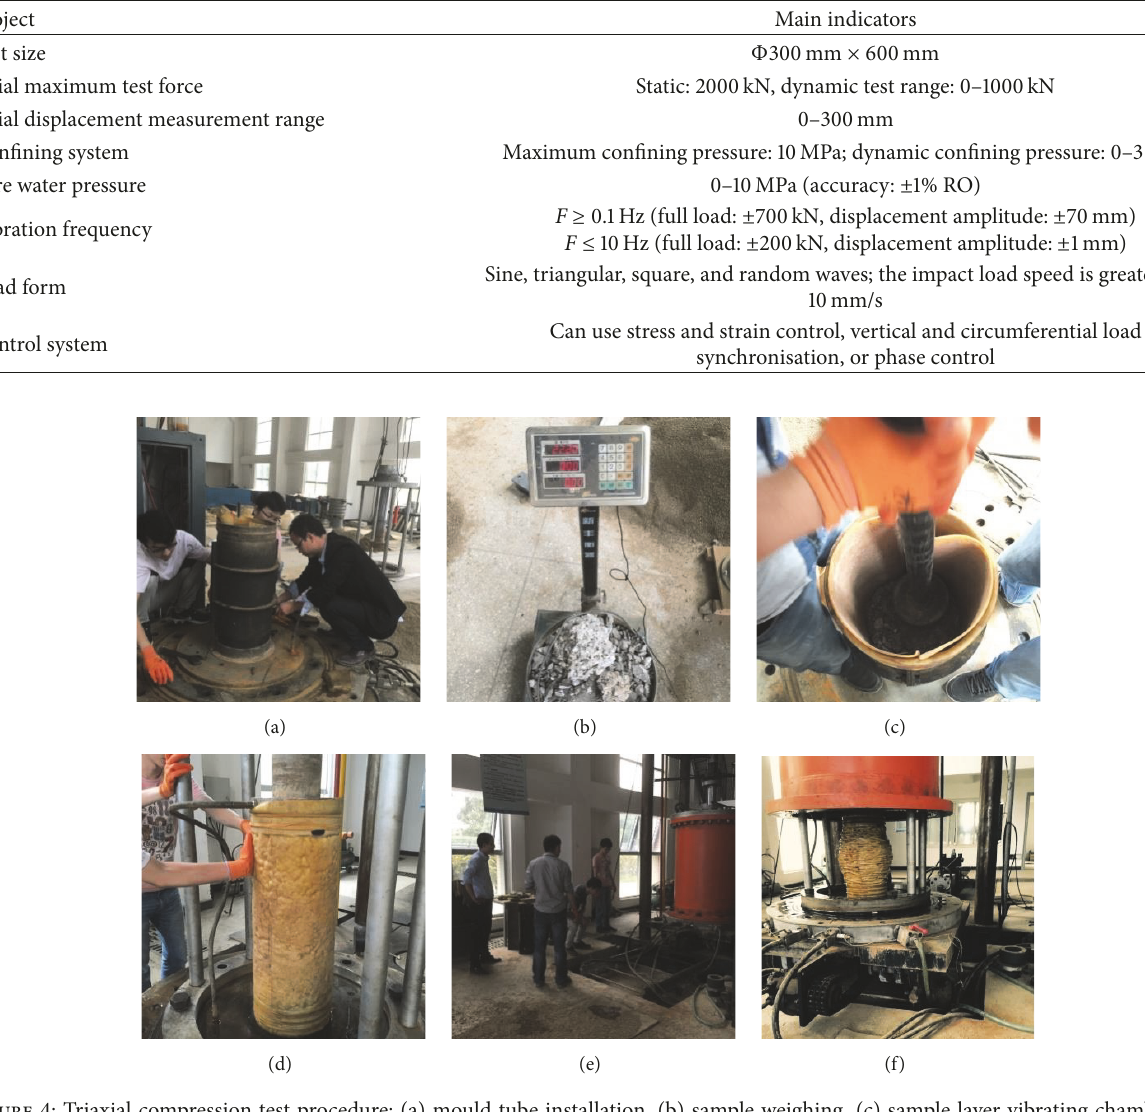
Figure 4: Triaxial compression test procedure: (a) mould tube installation, (b) sample weighing, (c) sample layer vibrating chamber, (d) sample vacuum forming, (e) sample saturation, and (f) sample shear